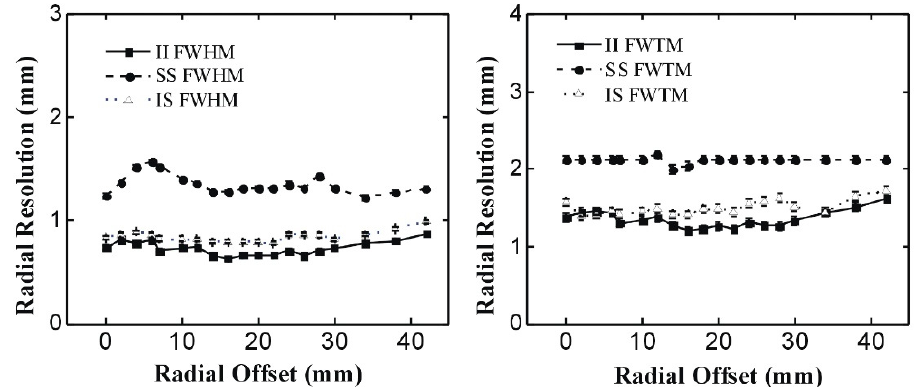
Figure 3. Radial resolution distribution through the PET system in the radial o ff sets; both full-width-at- half-maximum (FWHM)(left) and full-width-at-tenth-maximum (FWTM) (right) are shown.